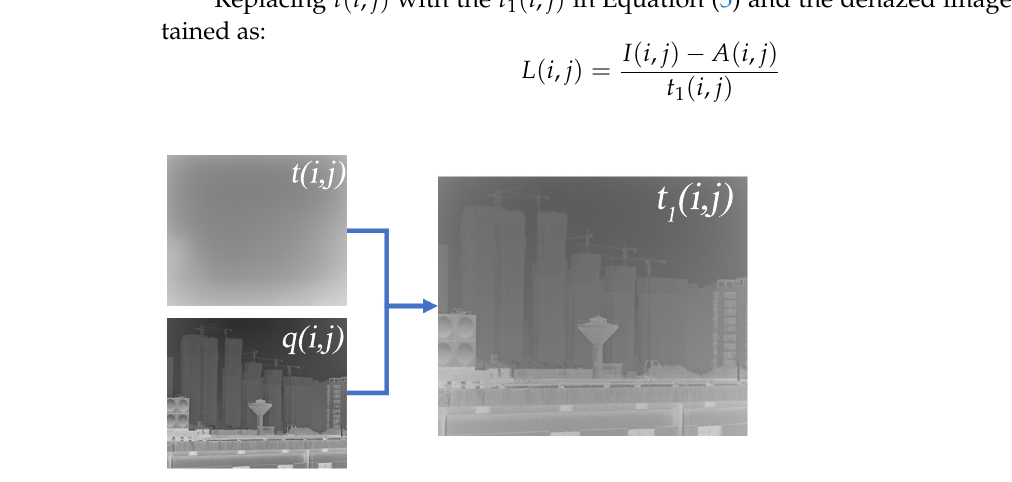
Figure 2. The process of combining q ( i , j ) with t ( i , j ) .